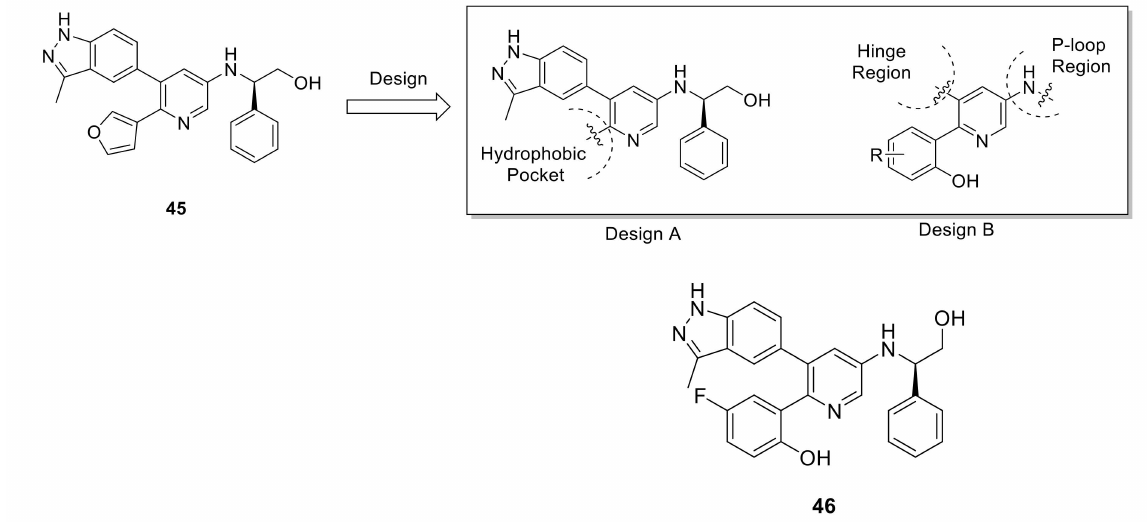
Figure 19. Structural-based design and chemical structures of compounds 45 and 46 . Reprinted with permission from Ref.